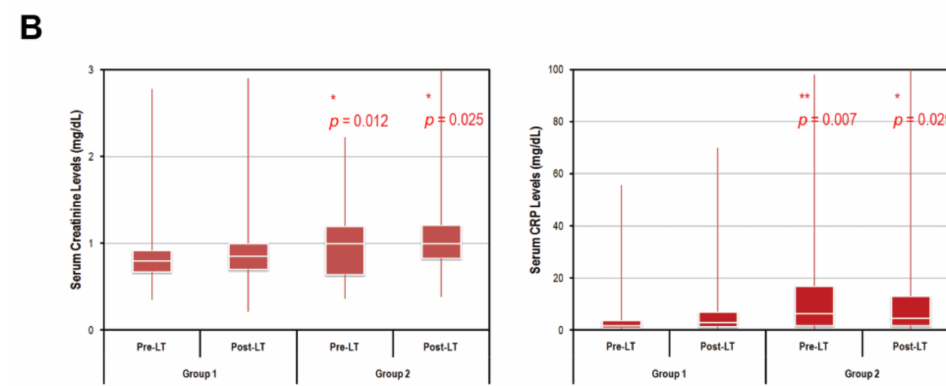
Figure 2. Trends of peritransplant lymphocytes, RBC, hemoglobin, creatinine, and CRP levels in LT patients of HCC with or without peritransplant high NLR. ( A ) The longitudinal lymphocyte and RBC counts as well as hemoglobin levels between 7 days pre-transplant and 30 days post- transplant were significantly lower in the PTH-NLR patients. Recovery of these values within one month after LT was remarkable in those patients without persistently high NLR (control group). ( B ) The Levels of both serum creatinine and CRP 7-day pre-transplant and 30-day post-transplant were significantly increased in PTH-NLR patients compared to those values in control patients.